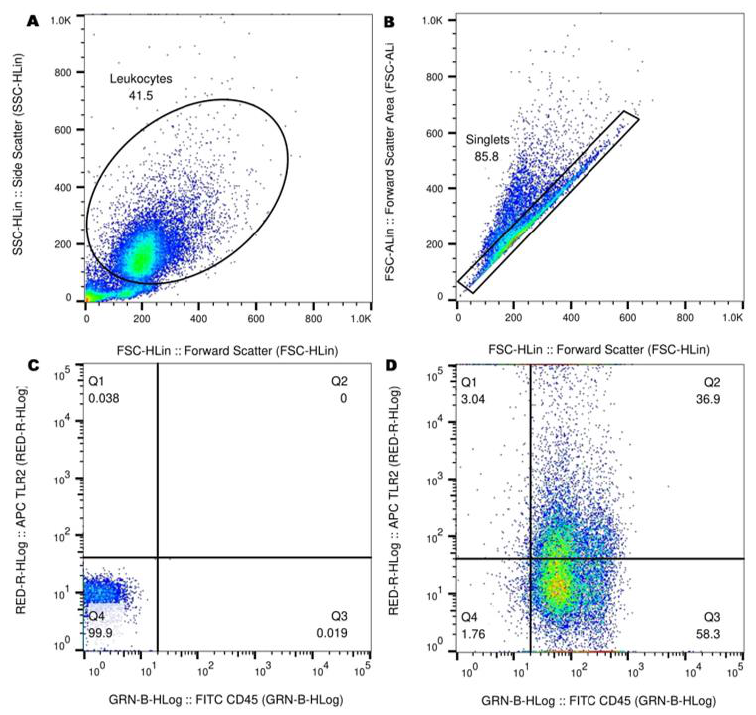
Figure 1. Gating of canine leukocytes using a representative sample from a healthy control. ( A ) The forward scatter-height (FSC-H) vs. side scatter-height (SSC-H) dot plot was used to define the population of interest, ( B ) followed by the exclusion of cellular debris and non-single cells (doublets, clumps) using the FSC-H vs. FSC-area (FSC-A) dot plot. ( C ) Unstained controls were used to delin- eate positive and negative populations, ( D ) with representative positive staining shown for CD45 and TLR2.